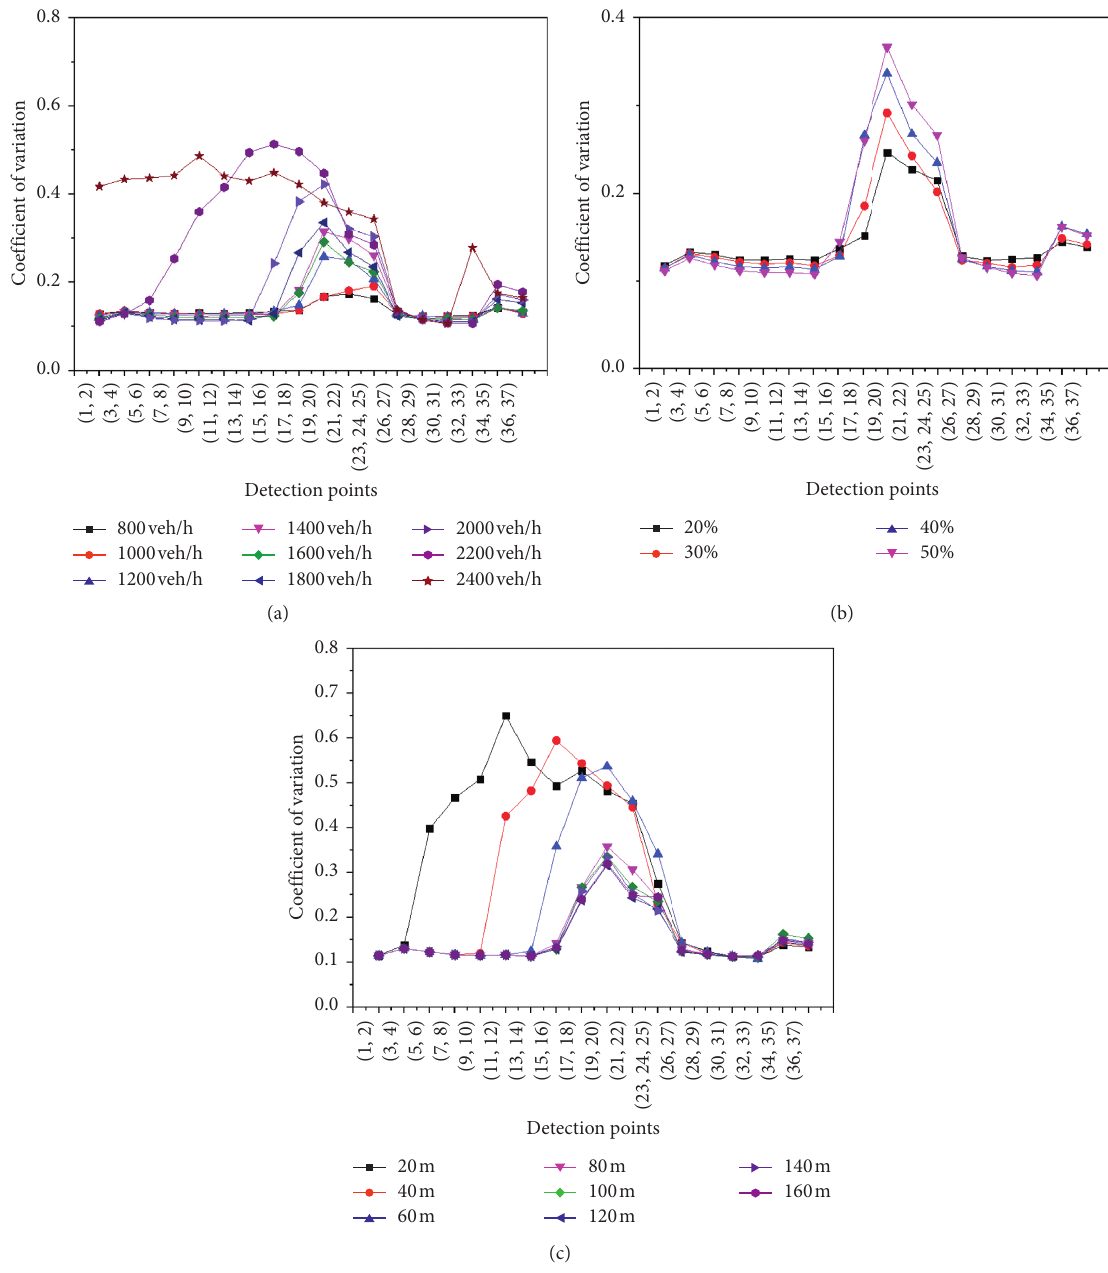
Figure 5: Coefficient of variation varies with each factor. (a) Coefficient of variation varies with traffic volume. (b) Coefficient of variation varies with the proportion of large vehicles. (c) Coefficient of variation varies with the length of the transition